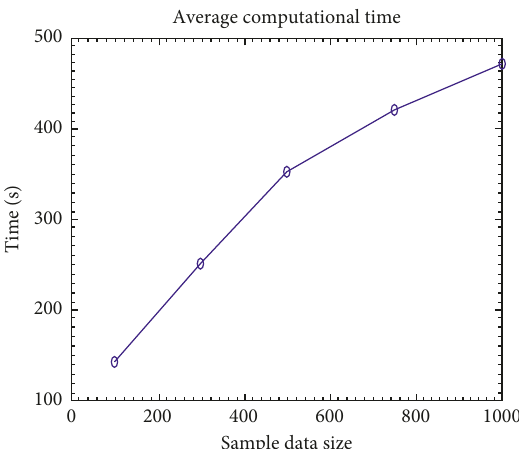
Figure 14: Computational time on the tested sample dataset.